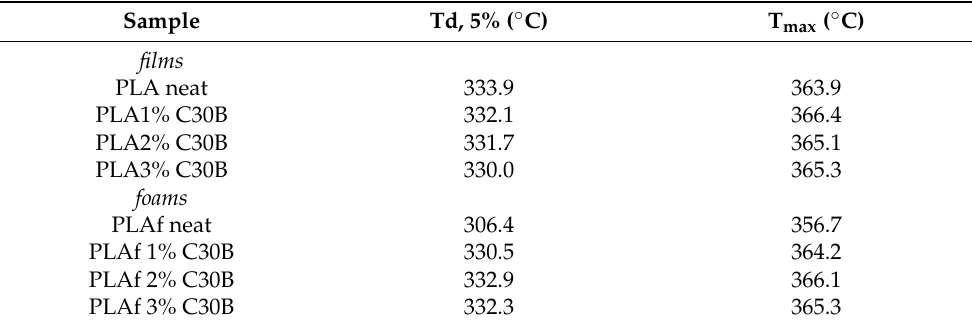
Figure 10. TGA and their derivative DTGA (insert) curves of PLA composites of films and foams. Table 3. TGA parameters of PLA bionanocomposite films and